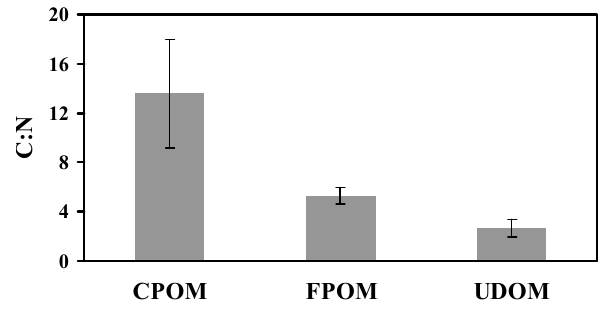
Fig. 3 Fig. 3. Spatial-averaged mole C:N ratios for the coarse particulate organic matter (CPOM), fine particulate organic matter (FPOM), and ultra-filtered dissolved organic matter (UDOM) size fractions based on values at the 13 sampling stations. Bars represent standard deviations.